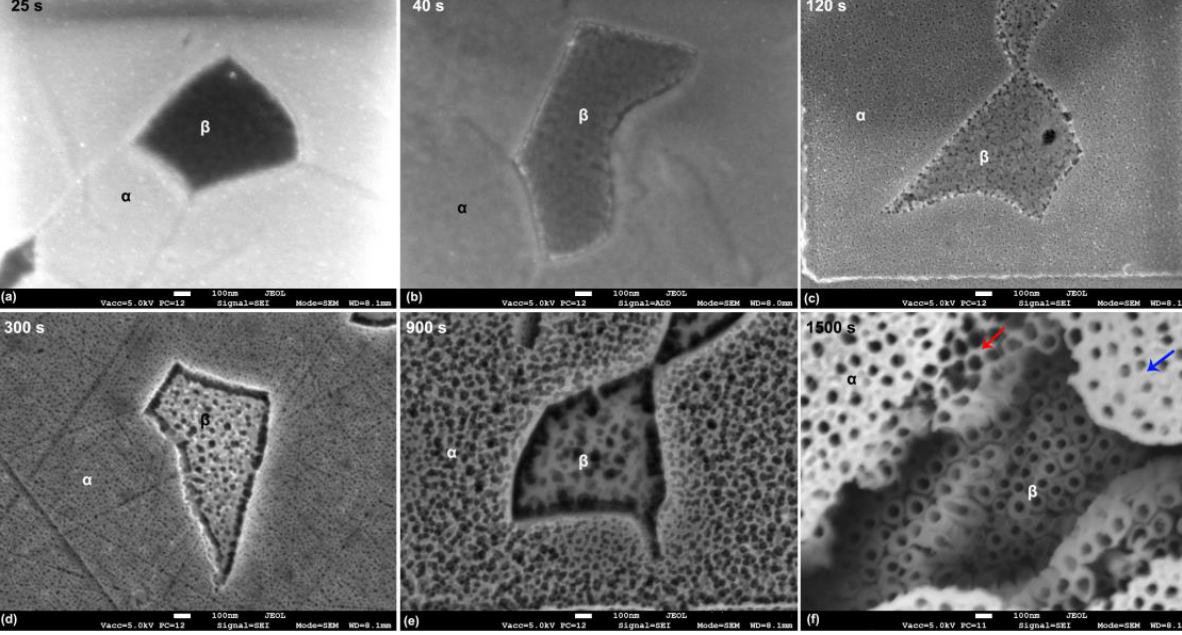
Figure 9. FESEM micrographs of samples anodized at 60 V at ( a ) 25 s, ( b ) 40 s, ( c )120 s, ( d ) 300 s, ( e ) 900 s, and ( f ) 1500 s. AFM topography maps revealed that, after only 25 s of anodization (Figure 8a), the β -phase grains appeared higher than the α -phase grains, and the grain boundaries